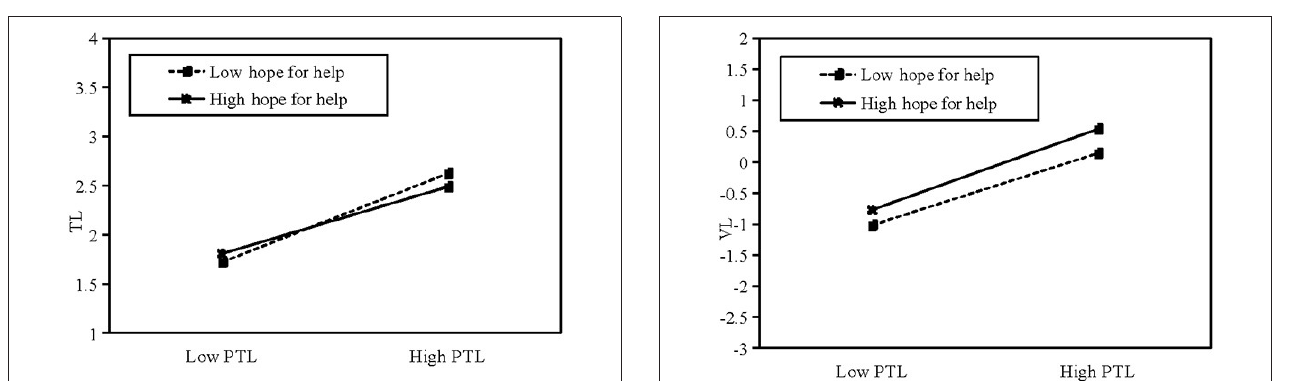
t = 1.11, ρ > 0.1) is not significant, whereas γ 4 ( γ 4 = 0.095, t = 3.21, ρ < 0.01) and δ 4 ( δ 4 = 0.092, t = 5.07, ρ < 0.01) are positive and significant; this indicates that H4 and